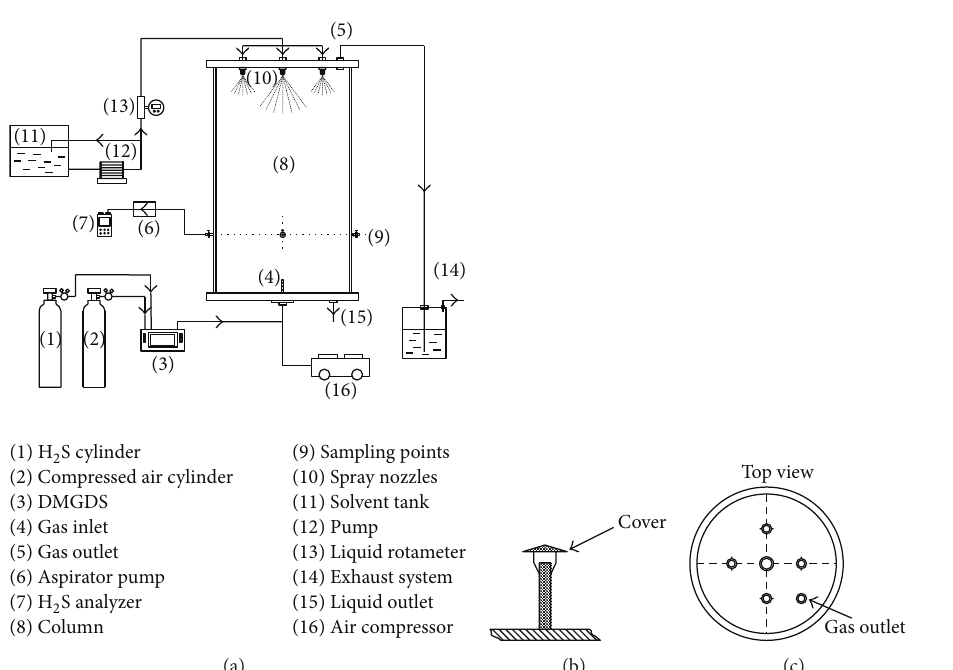
Figure 1: Schematic diagram showing the experimental setup: (a) overall layout; (b) gas inlet; (c) top